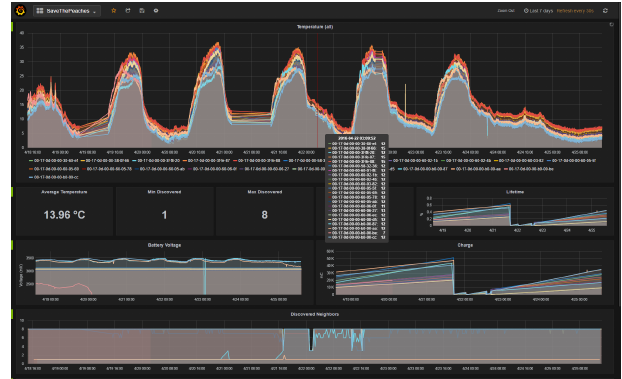
Figure 12. Example dashboard showing the last 7 days of data.